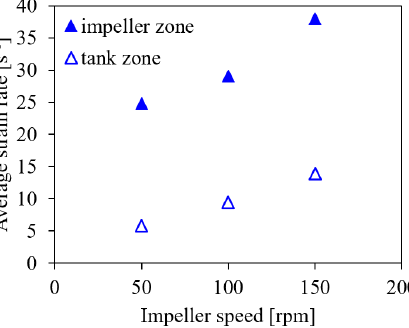
Figure 8. Average strain rate in the impeller and the tank zones for V = 1.7 L, Q = 50 mL min − 1 and the microporous sparger for different impeller speeds of 50 rpm, 100 rpm, and 150 rpm (conditions #6, #4, and